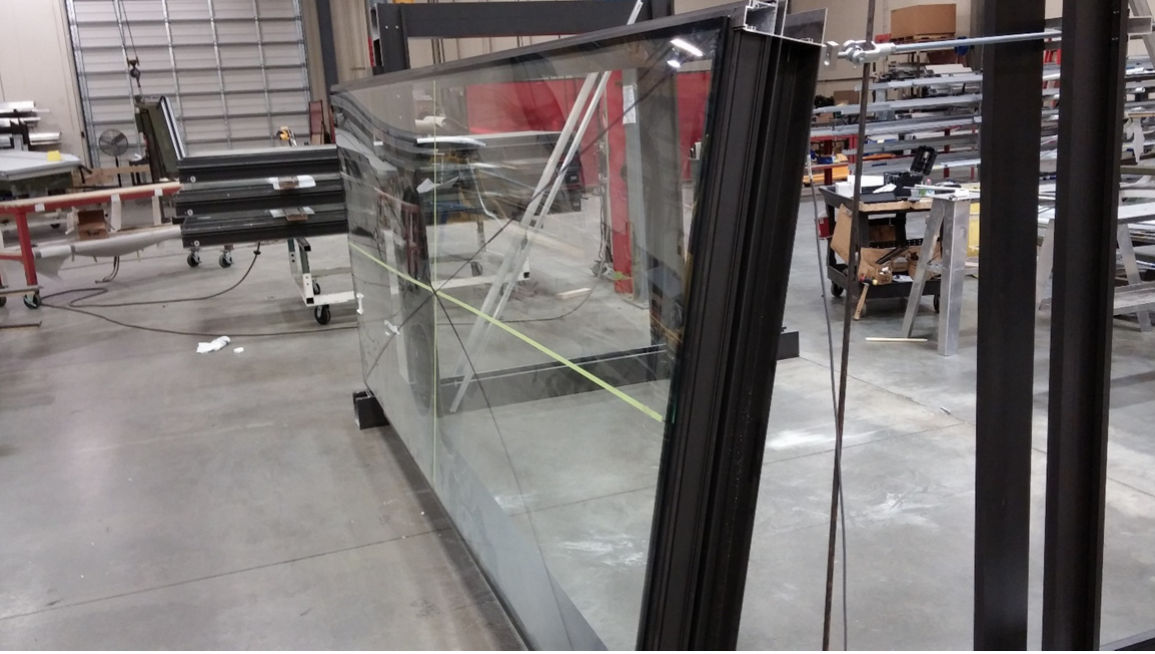
Fig. 7 Cold Formed Test of 1525mm x 3658mm Glazed Frame.